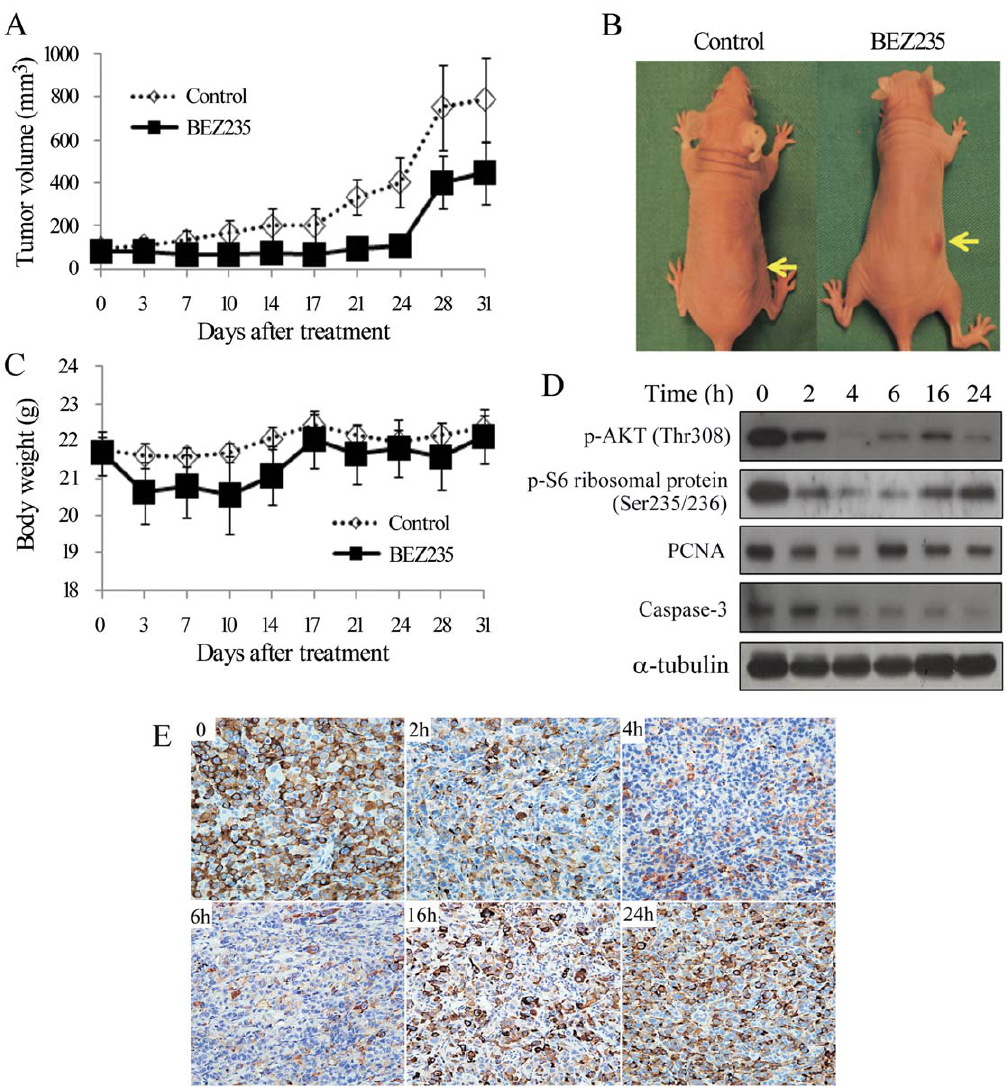
differences of tumor volume between BEZ235 and control group achieved statistical significance on days 21 and 24. Significance was lost on day 28, 4 days after treatment had been discontinued. B, representative mice with 8505C xenograft tumors (arrows) were photographed on last day of treatment (day 24). C, BEZ235 did not result in any weight loss, in treated and control mice (P . 0.05 for both comparison). D, BEZ235 represses p-AKT (Thr308) and p-S6 ribosomal protein (Ser235/236) by 2 hours and caspase-3 by 4 hours in vivo. PCNA was slightly reduced at early period. E, expression of p-S6 ribosomal protein in tumor cells is detected by immunostaining at the indicated periods (magnification, 6 200). These results were in consistent with Western blot